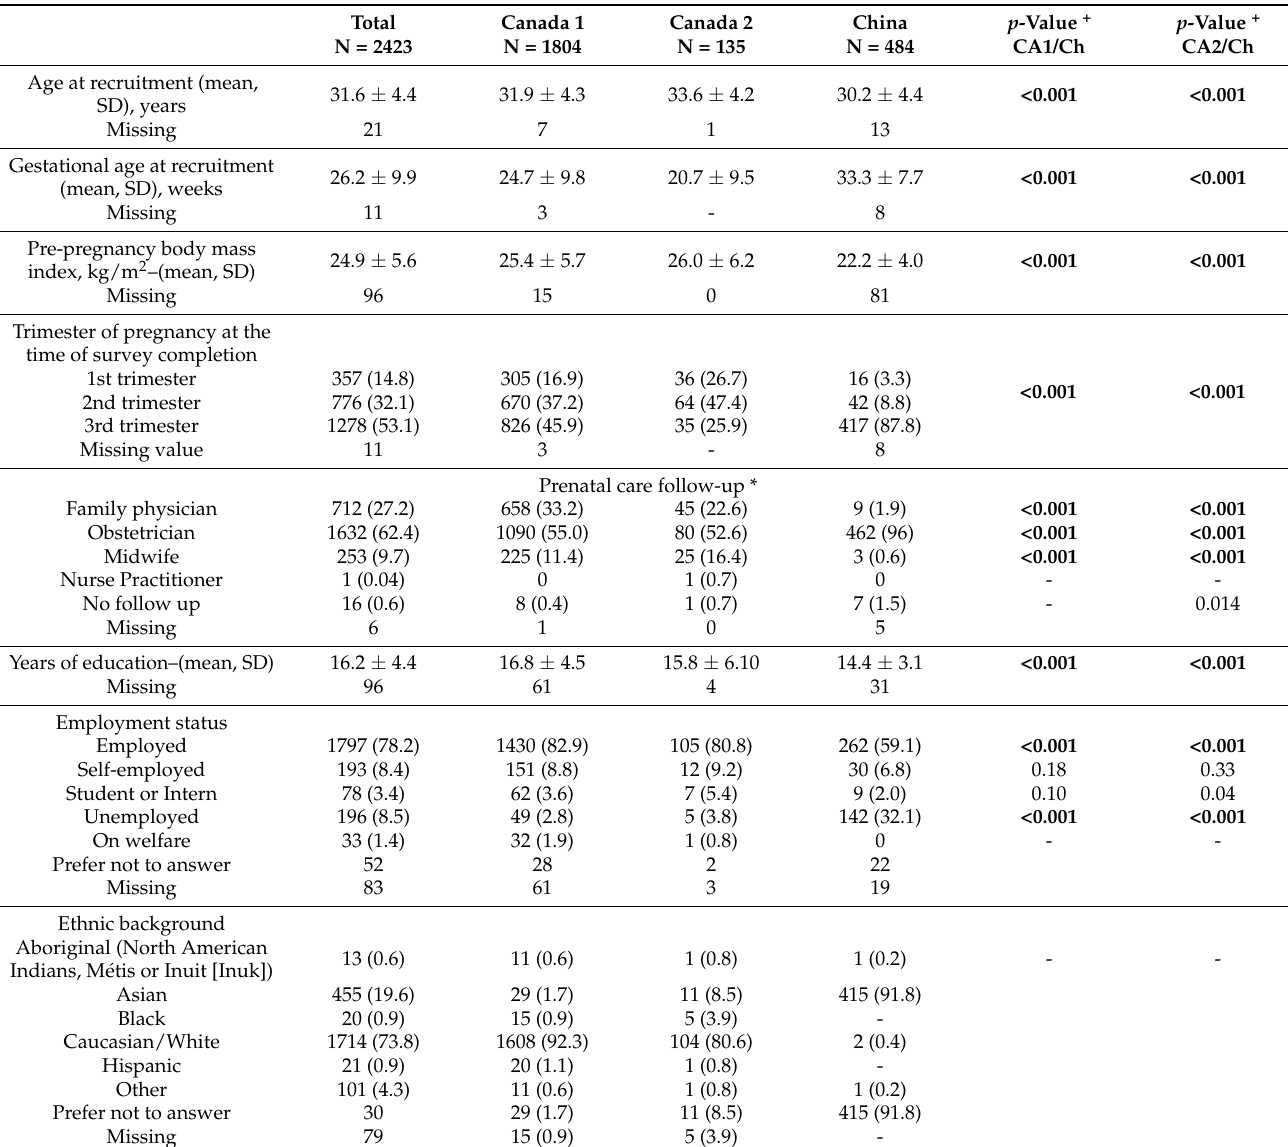
Table 1. Characteristics of pregnant